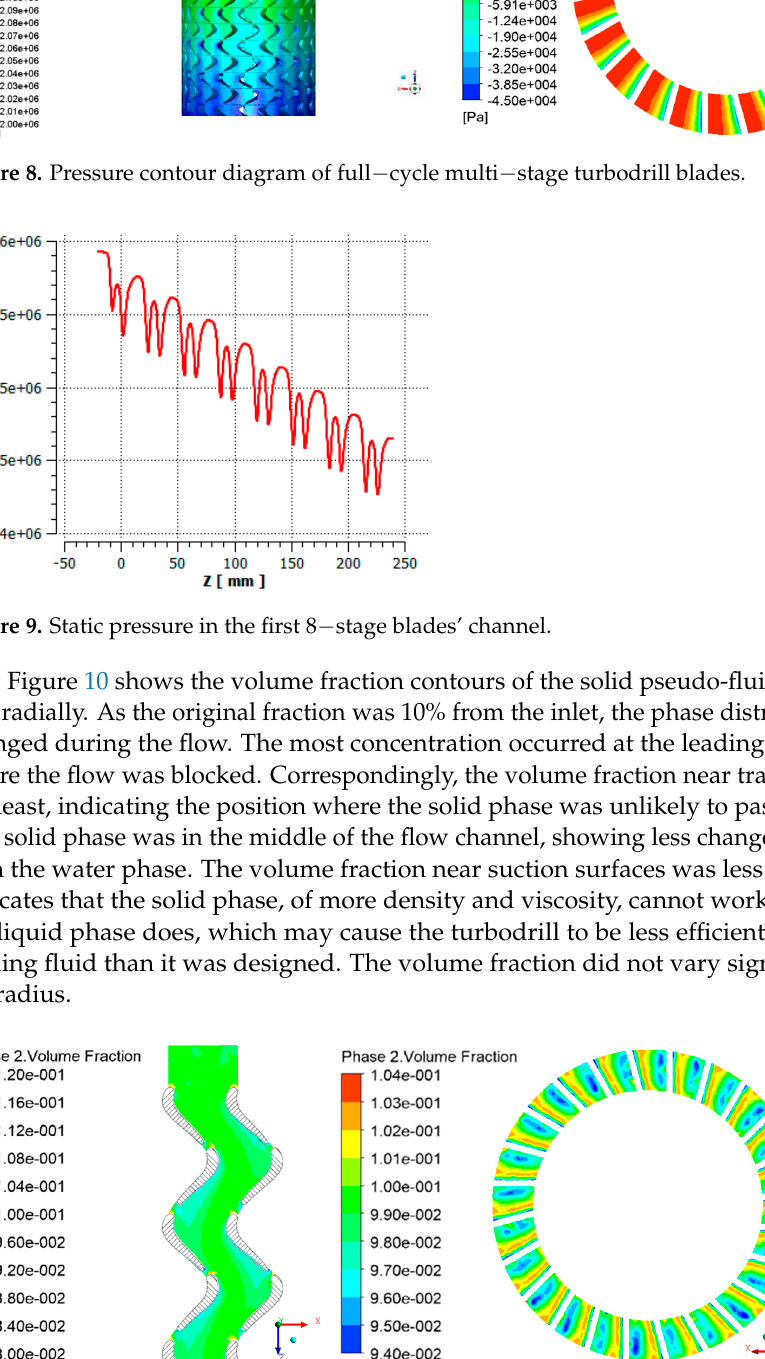
11 of 17 Figure 7. Streamline diagram of single − blade multi − stage turbodrill blades. Figure 8 shows the pressure contour diagrams of full-cycle multi-stage turbodrill blades, axially and radially. It can be seen from the figure that the pressure contour dia- gram of the overall watershed of the 100-stage blades decreased from the first stage to the last stage and there was an obvious pressure gradient in the flow path. Figure 9 shows static pressure versus axial position in a single flow channel. Due to the centrifugal force as Equation (18) indicated, pressure in Figure 9 was lower than that of the outer wall in